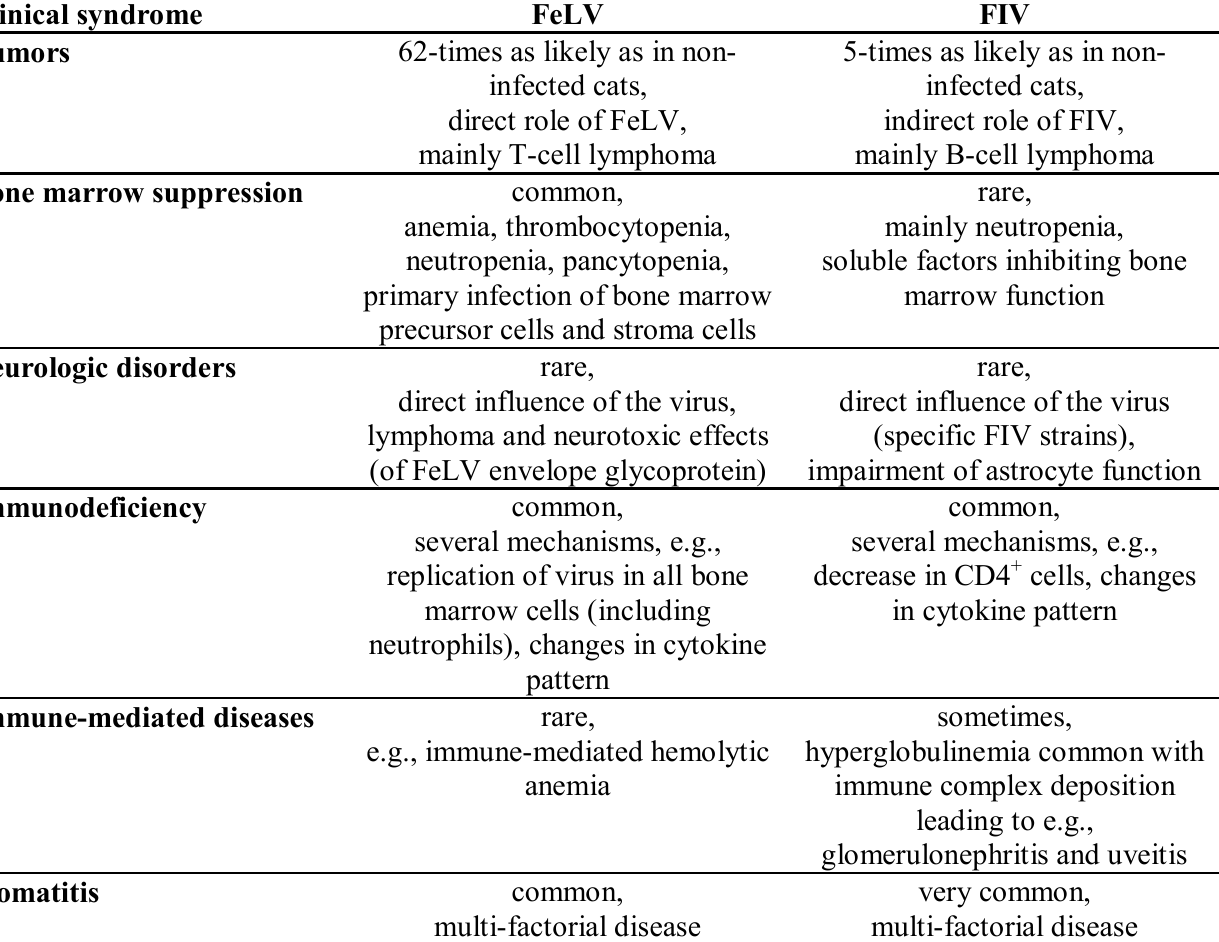
Table 2. Comparison of clinical signs and their main pathomechanism in feline